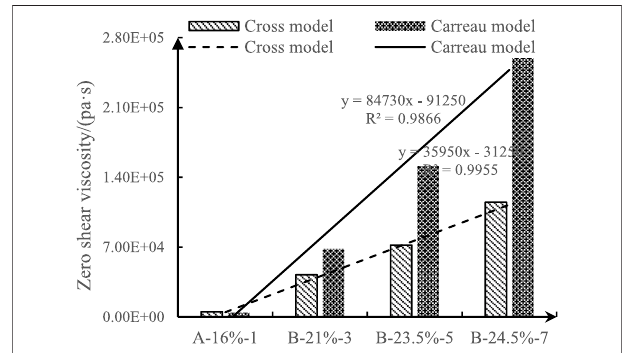
FIGURE 2 | ZSV of modi fi ed asphalt under different calculation models.